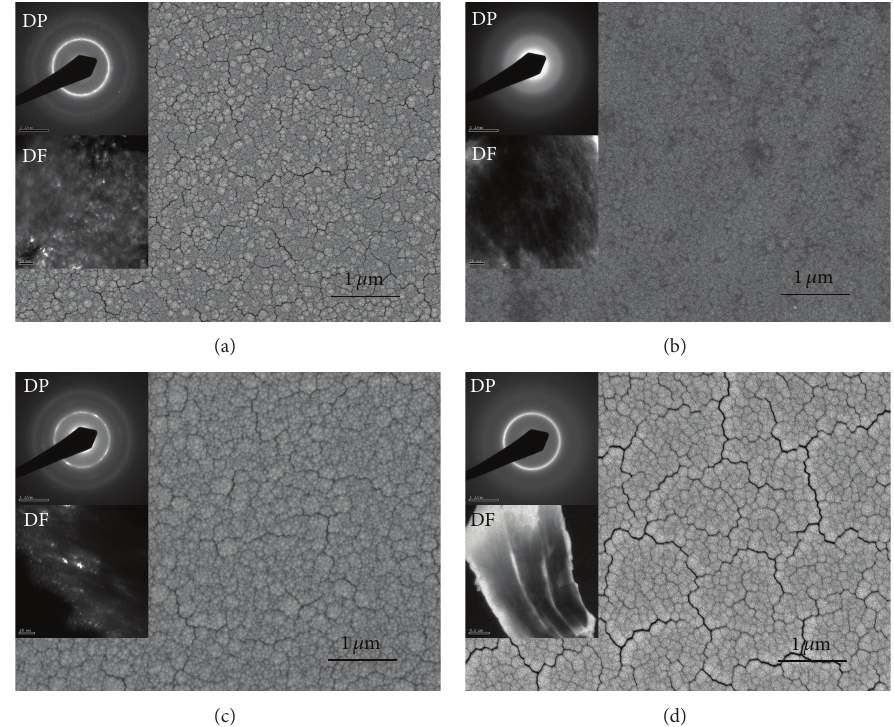
Figure 1: The plan-view micrographs of the as-deposited (a) FCN film; (b) CFCN film; (c) AFCN film; and (d) TFCN film, respectively. The insets are the corresponding SAD (marked by DP) and DF image (marked by DF) of each as-deposited thin film.